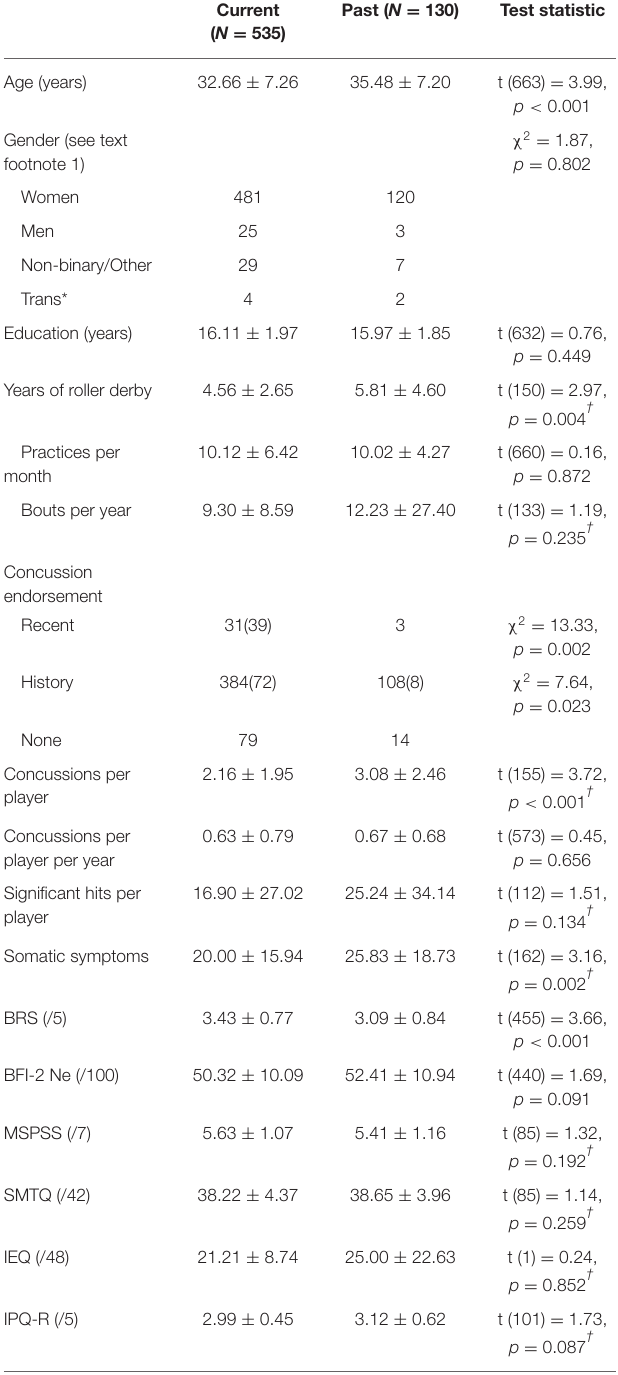
TABLE 1 | Sample description and demographics by roller derby